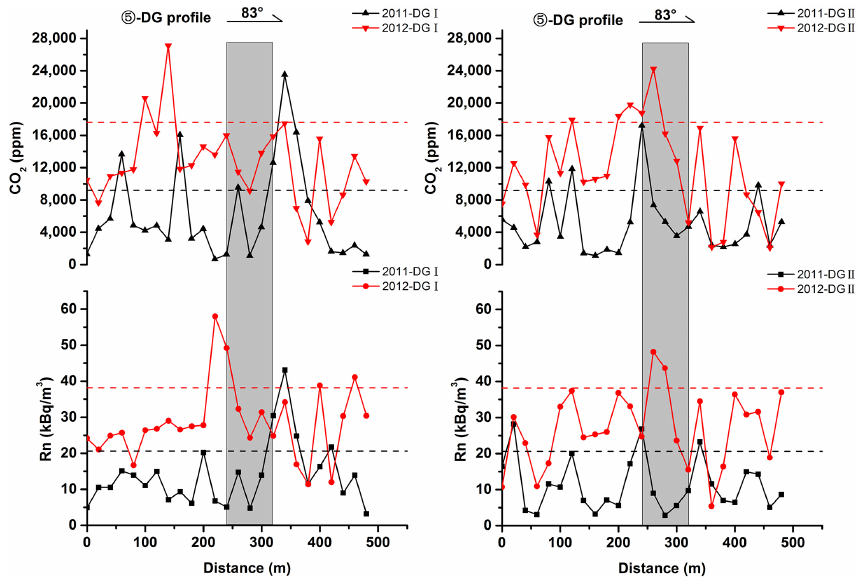
Figure 8. Rn and CO 2 concentrations along the DG profile across the Xiadian Fault. The shaded bar represents the location of the fault. The black and red dotted lines represent the anomaly threshold of soil gas in 2011 and 2012, respectively. The arrow at the top (with number above) represents the direction of the profile.